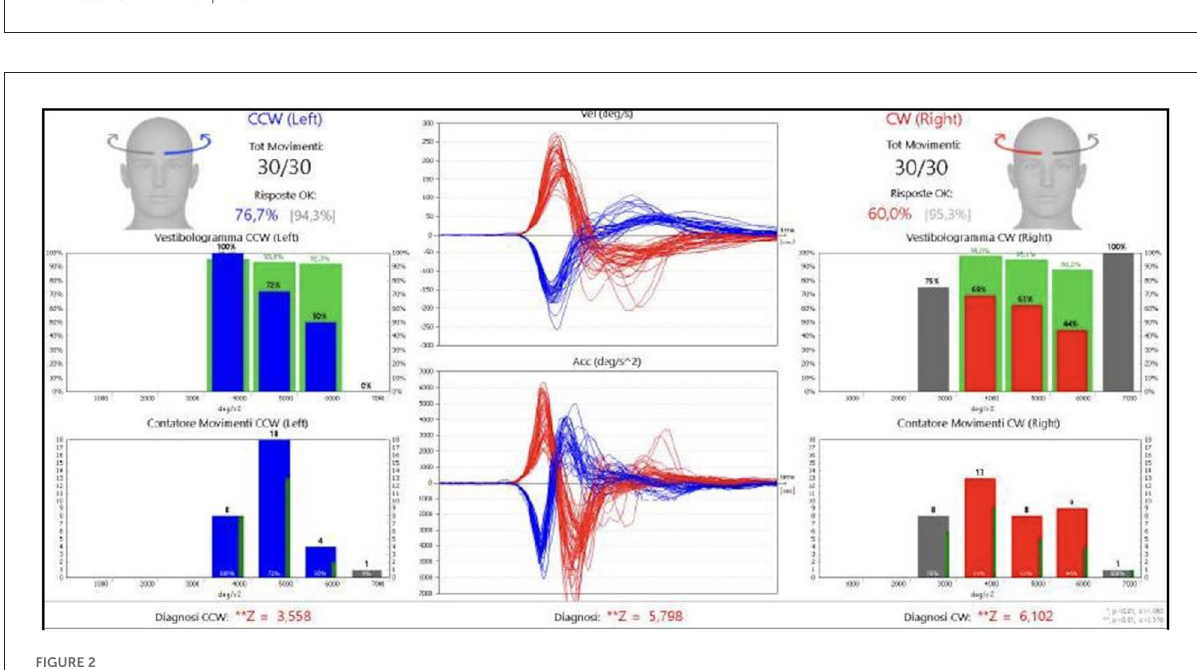
FIGURE1 fHIT results in normal patient.